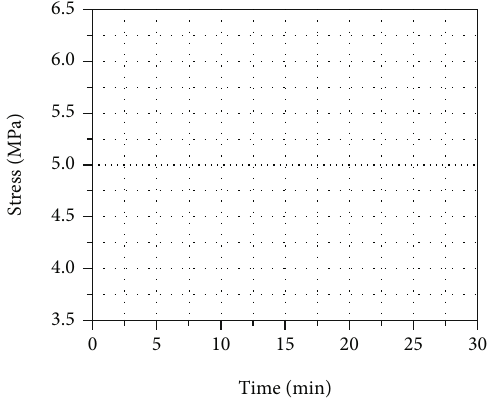
Figure 14: Observed value of con fi ning